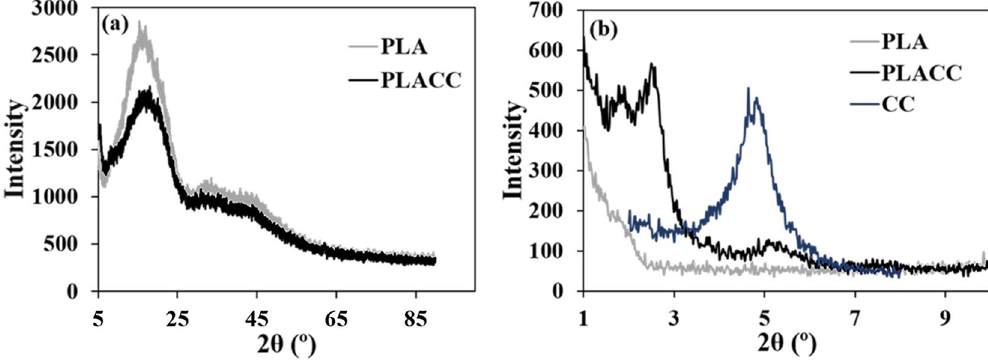
Figure 2. Physical characteristics analysis. ( a ) Crystallinity of PLA and PLACC as determined via XRD. ( b ) Exfoliation of CC in PLACC as determined via